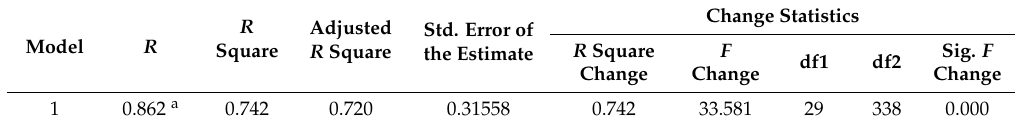
Table 10. Showing the value of R square.